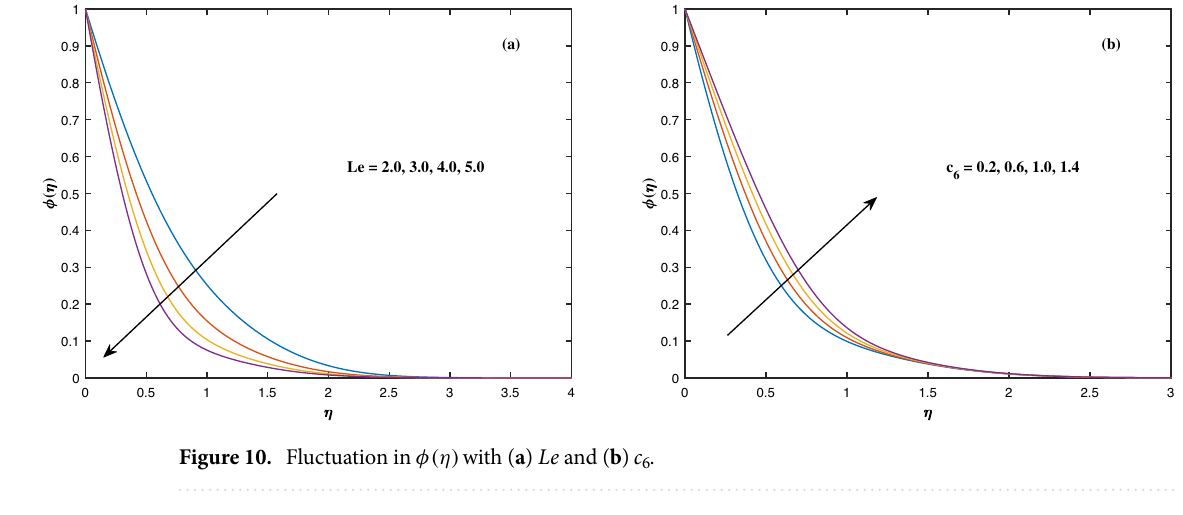
Figure 10. Fluctuation in φ(η) with ( a ) Le and ( b ) c 6 .